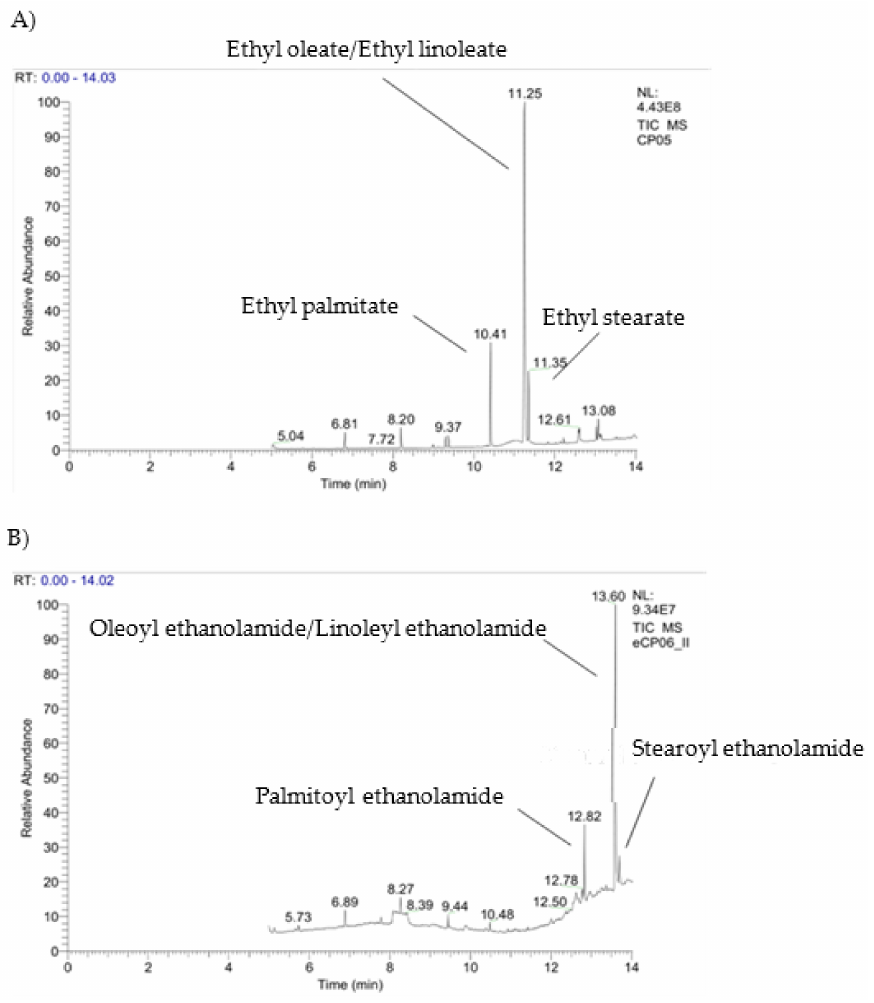
Figure 3. GC-MS chromatogram of the Novozym ® 435-catalyzed preparation of ( A ) ethyl esters and ( B ) ethanol amides of oleoyl, linoleoyl, stearyl, and palmitoyl acids in Cp